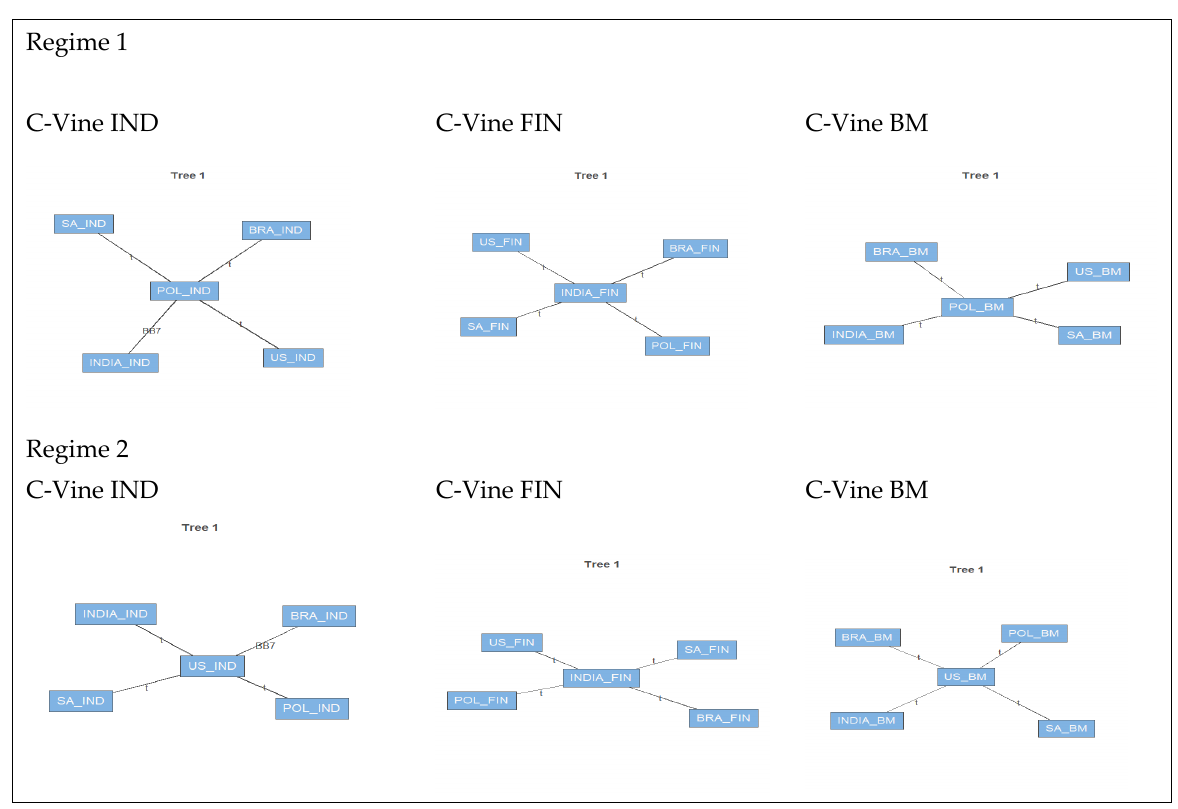
Figure 2. The first tree structures of regime 1 and regime 2 of the C-Vine model, and the correspond- ing bivariate copulas for industrials sectors (IND), financials sectors (FIN), and basic materials sec- tors (BM) of US, Brazil, India, Poland, and South Africa.